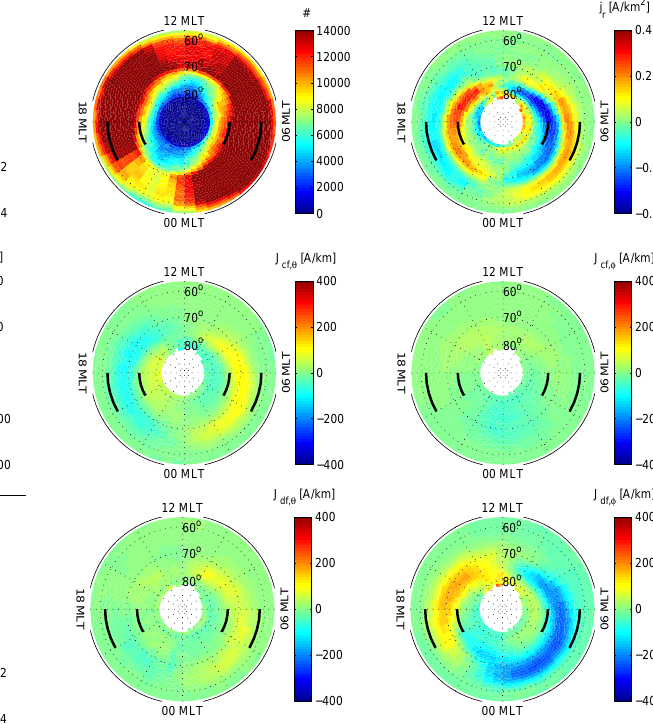
Fig. 4. Combined data from both hemispheres. J cf,φ and J df,θ are also shown in addition to J cf,θ and J df,φ .